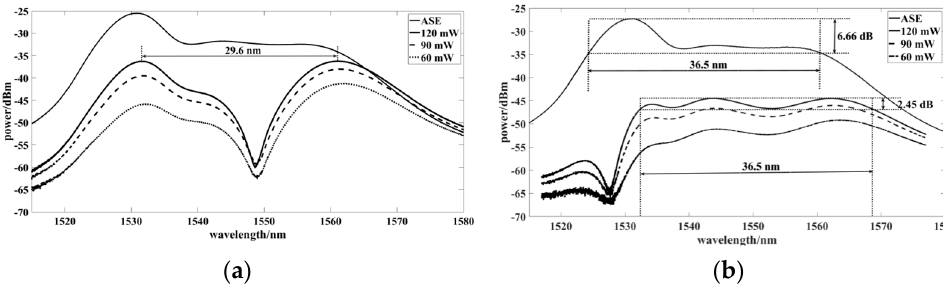
Figure 3. Comparison diagram of ASE gain spectra before flattening and after flattening at the reflection port ( a ) and at the transmission port ( b ).